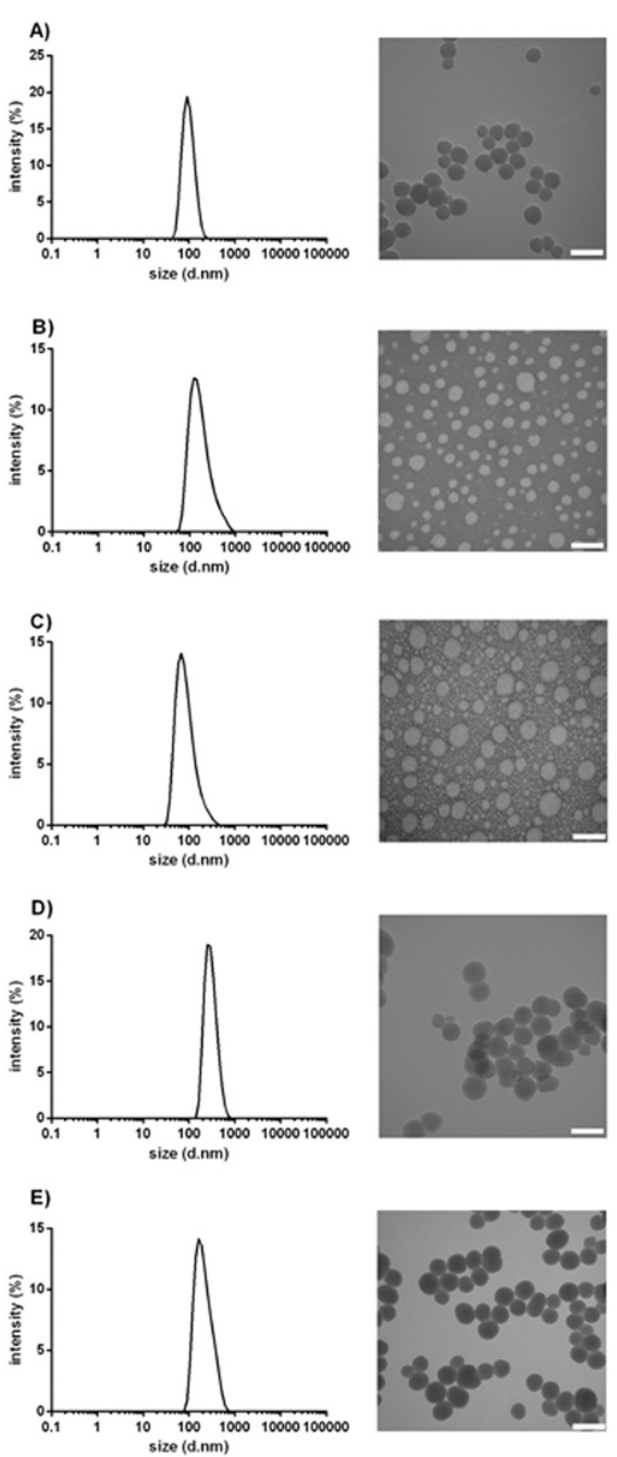
Fig 1. TEM images of nanoparticles A) silica, B) PLGA, C) PCL, D) amine functionalized silica and E) pegylated silica. Scale bar is 100 nm.